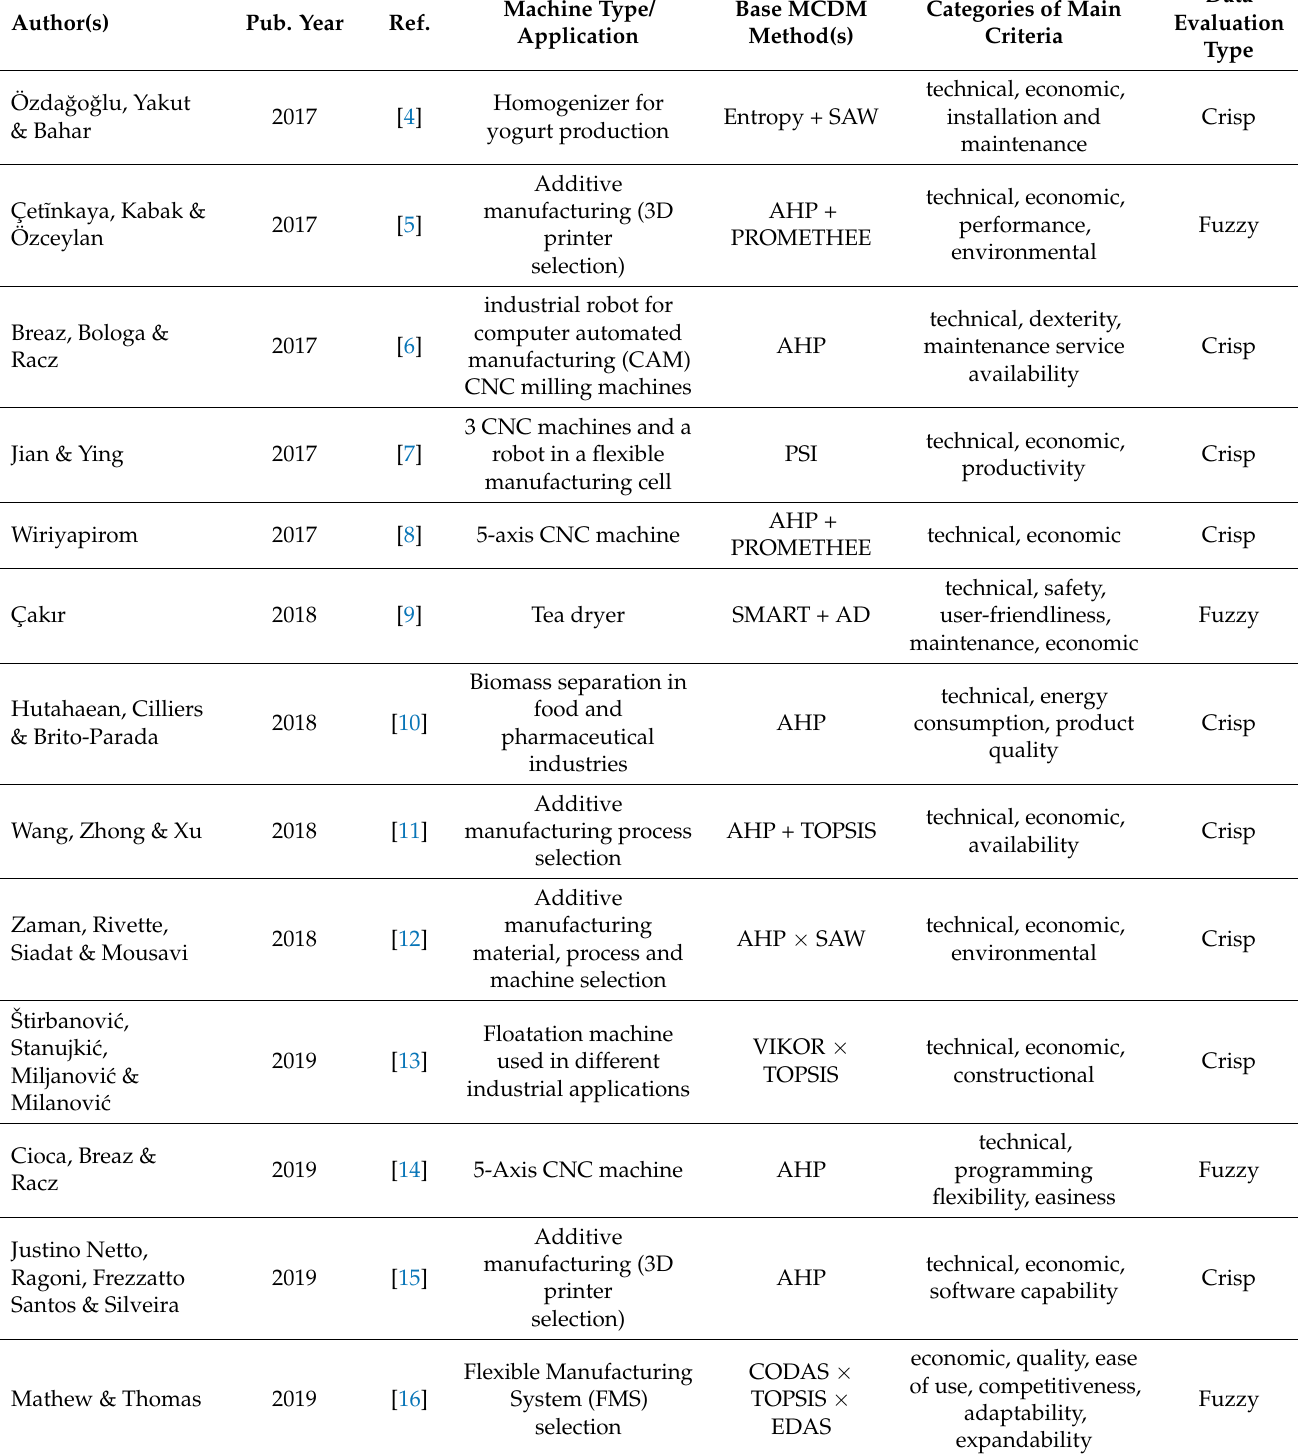
Table 2. Characteristics of surveyed papers in